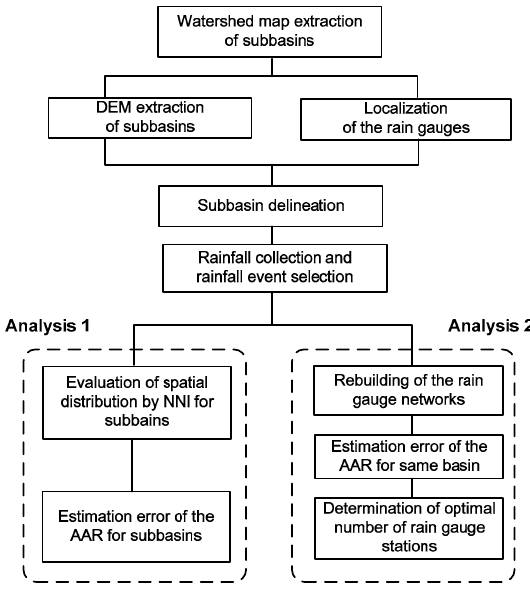
Figure 1. Schematic Diagram of a Methodology for Estimation of AAR and its Error.